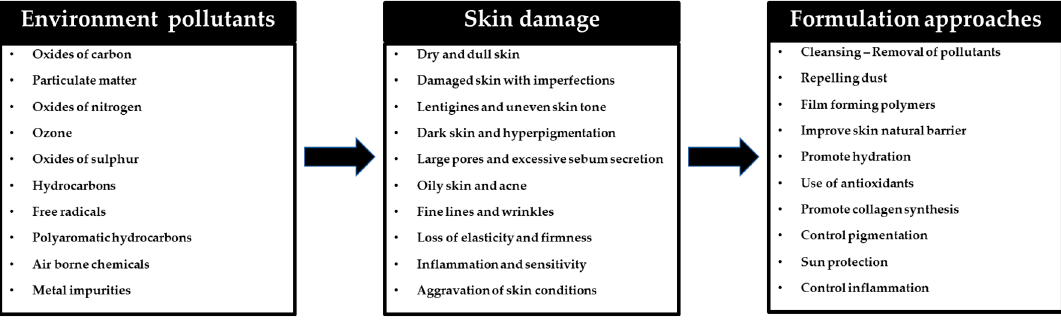
Figure 1. Environment pollutants, skin damage and guidelines for produce design.